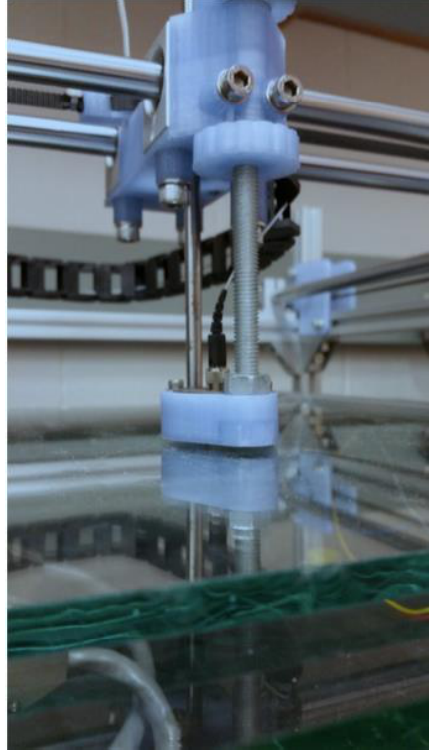
Figure 1. Closeup of the x-carriage z-axis adjustment assembly.